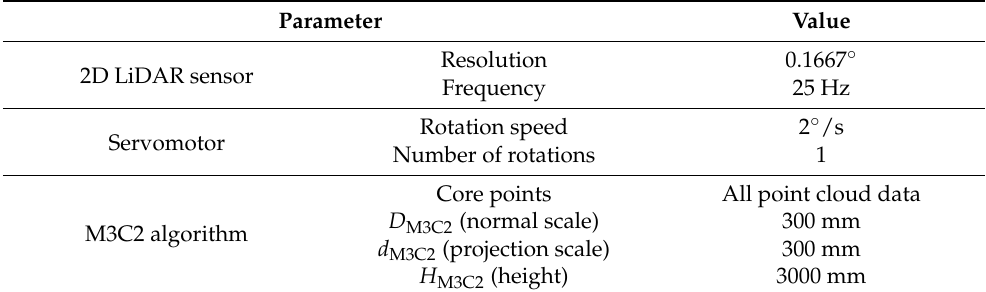
Table 3. Main parameters of the retaining wall displacement measurement hardware and M3C2